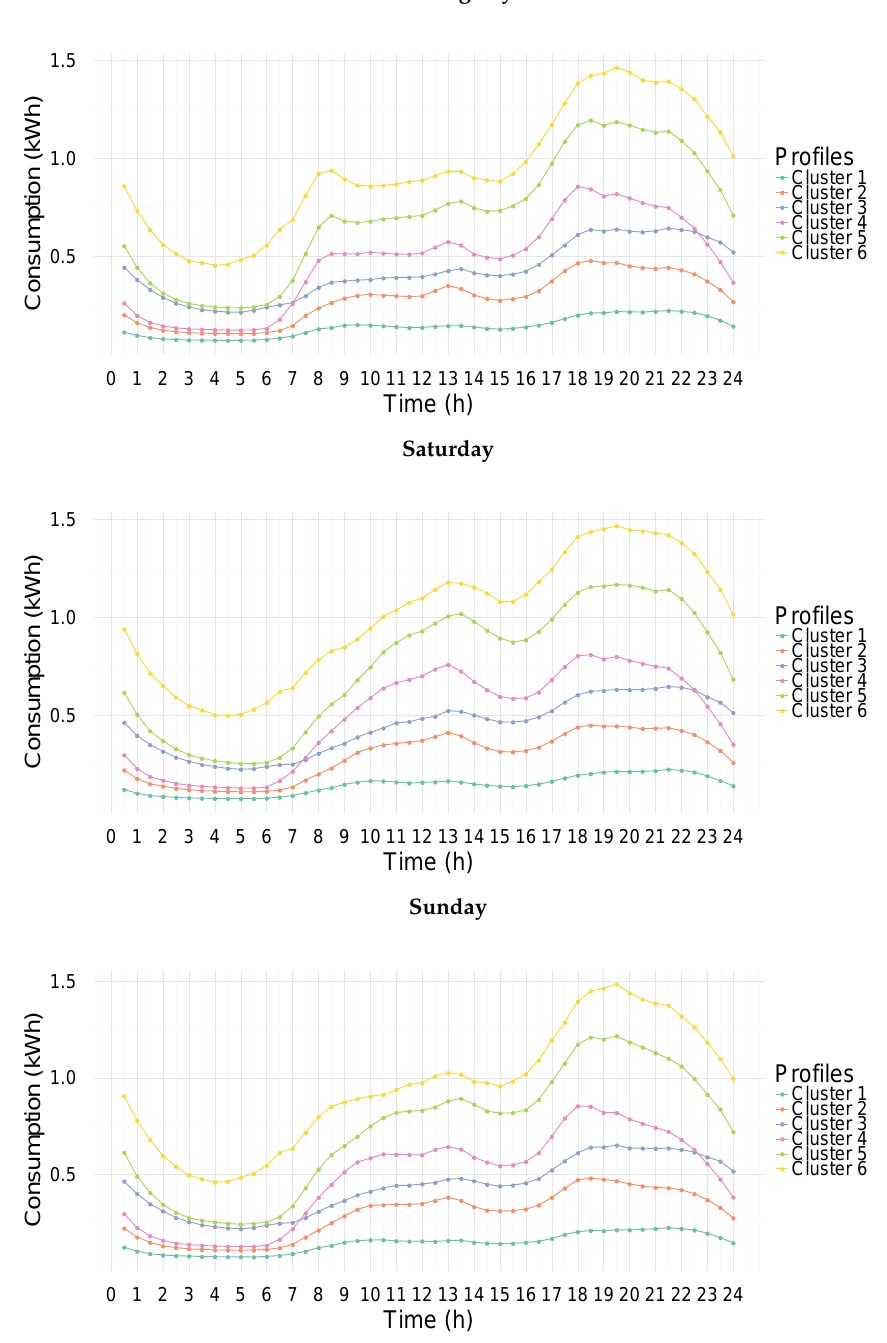
Figure 7. Electricity consumption profiles for the six clusters during Saturday, Sunday and working days for one year’s